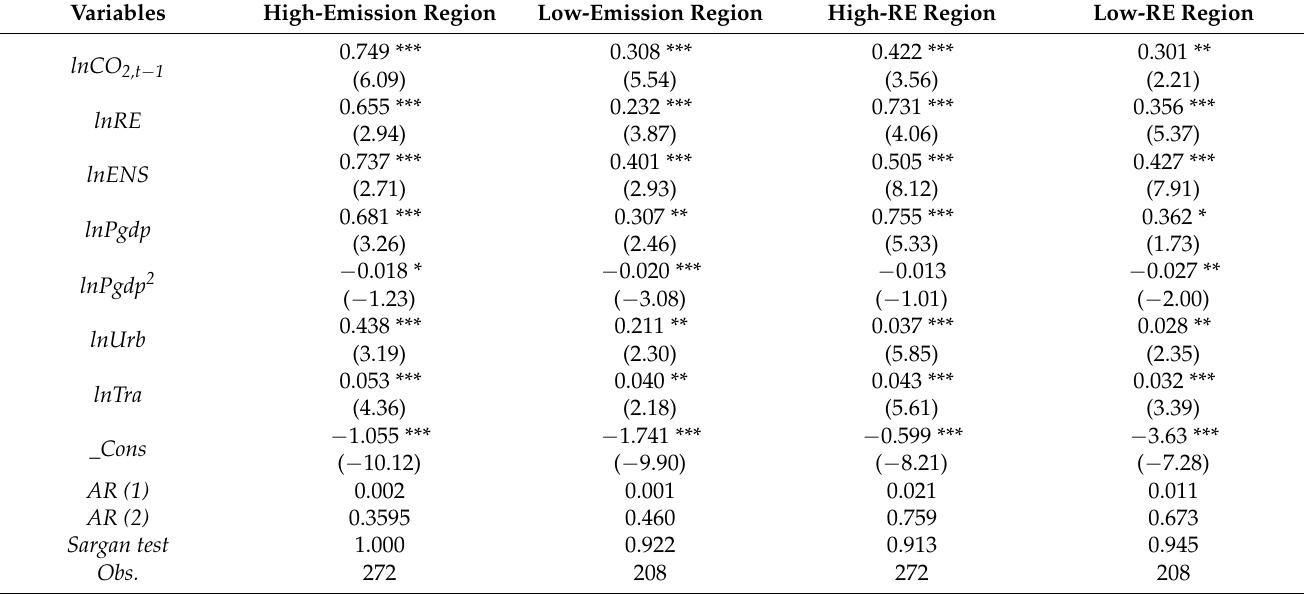
Table 7. Results of the regional heterogeneity analysis.